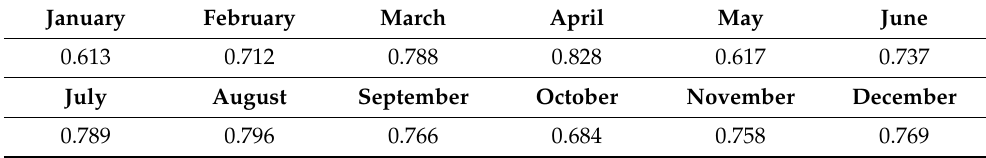
Table 3. Verification of calculated results of SST– ACC value